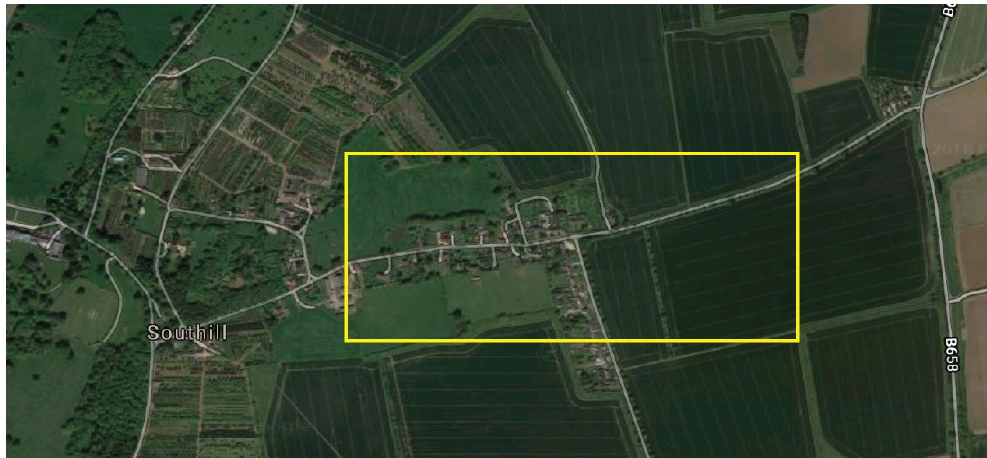
Figure 19. Screenshot of Google Maps showing the geofenced area [25].